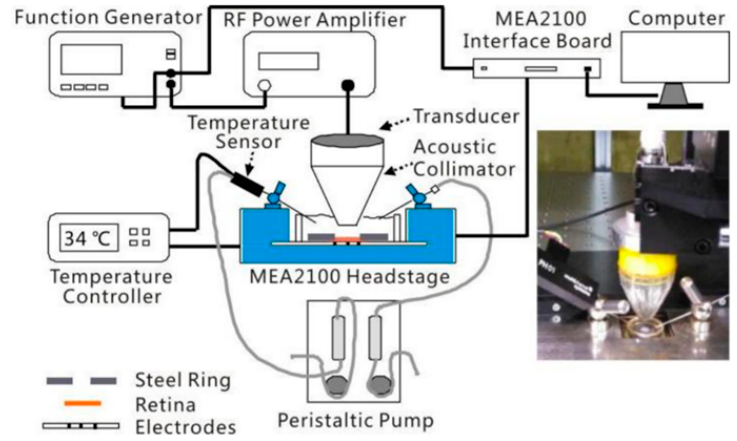
Figure 3. An experimental setup for in vitro retinal stimulation with a single-element transducer. (Image from Jiang et al., 2018 [38].)